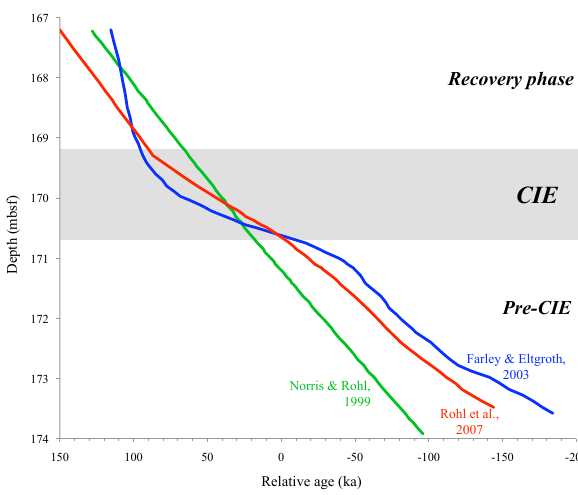
Fig. 3. Relative age (ka) vs. depth (mbsf) according to to the three age models discussed in the